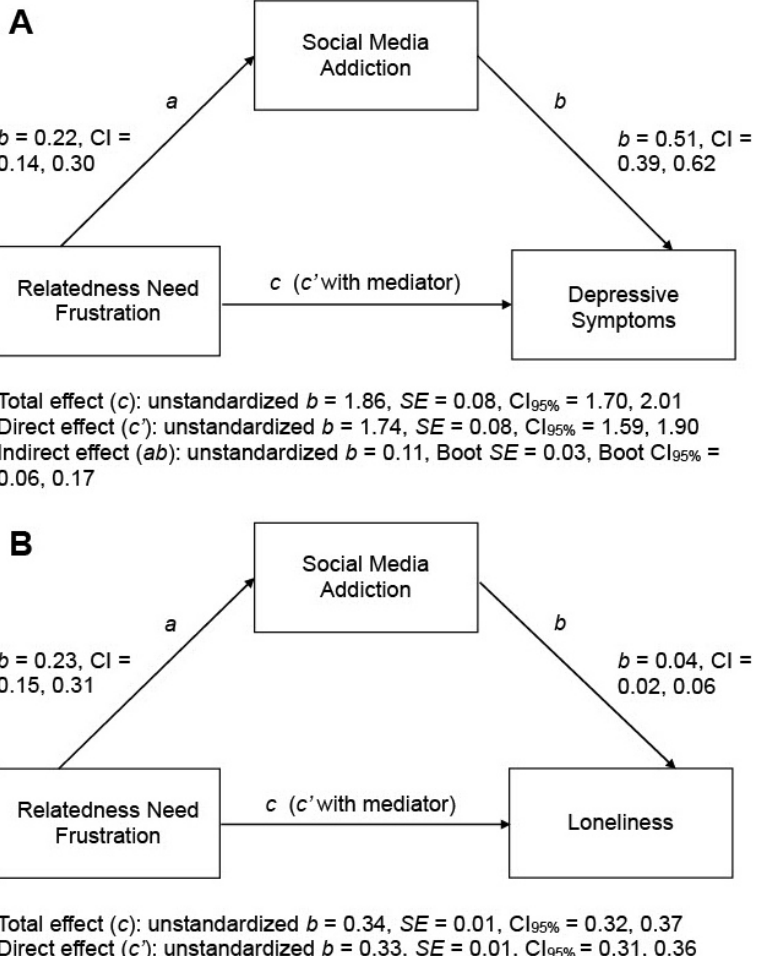
Figure 2. Summary of mediation analyses for testing the relatedness needs-as-motives model with depressive symptoms ( A ) or loneliness ( B ) as the criterion variable ( n = 1045). Bootstrap analysis of 5000 samples. Sex and age were entered as covariates. All displayed values are unstandardized path coefficients. Boot = bootstrap; SE = standard error; CI = confidence interval.